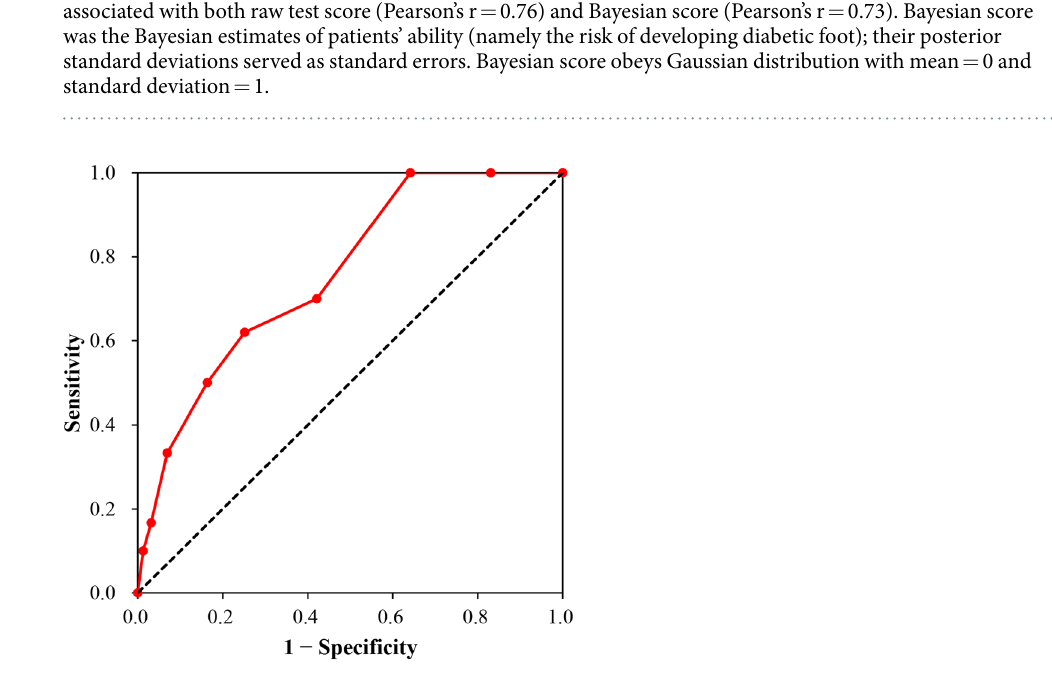
Figure 3. Receiver operating characteristic curve of the scale score to predict diabetes foot ulceration. Area- under-the-curve was 0.77 with 95% confidence interval of 0.61 to 0.93. The cut-off point with largest Youden index was 4.0, when sensitivity and specificity were 0.62 and 0.75